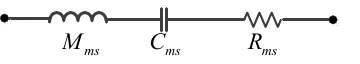
Figure 5. Equivalent circuit of mechanical domain.